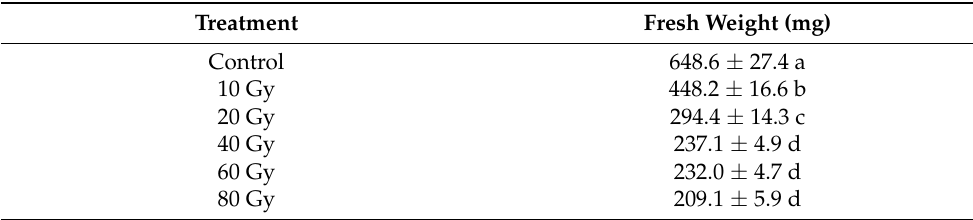
Table 1. Fresh weight of protocorm-like bodies of Dendrobium ‘Emma White’ one month after irradiation with gamma rays.